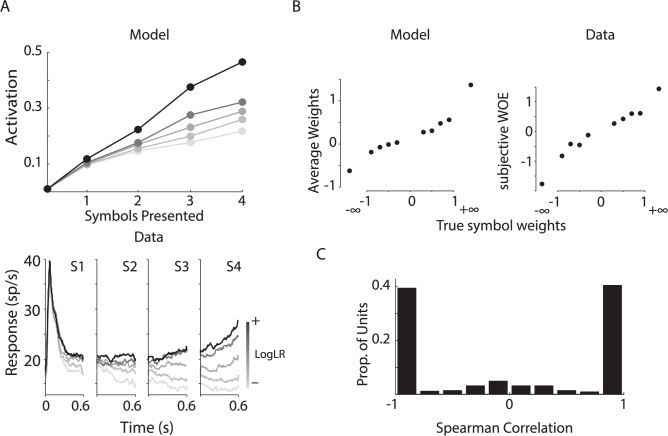
Tuning in the association layer in the probabilistic classification task.
A, Trials were subdivided in quintiles based on the log-likelihood ratio of the evidence favoring one target. Average activations of the four memory units of a trained model network (top; 100,000 trials) and LIP neurons (bottom, from [5]) depend on the log-likelihood ratio. B, Left, Average synaptic weights between input units representing symbols and an example memory unit are strongly correlated (ρ≈1, p<10-6) with true symbol weights. Right, Subjective weights assigned by a monkey as estimated from the performance data (from [5]). C, Histogram of Spearman correlations between average synaptic weights for symbols and true symbol weights for 396 memory units (AuGMEnT trained 99 of 100 simulated networks to criterion). Note that there are also units with zero correlation that do not contribute to the mapping of the symbols onto Q-values. These units were accompanied by other association units with stronger correlations.